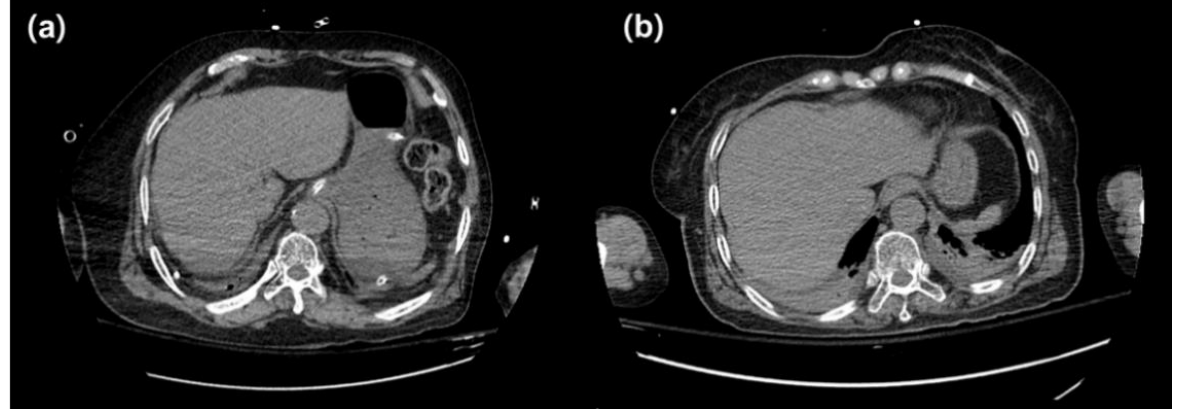
Figure 2. Abdominal CT images of patients with arms-down position in groups A and B. ( a ) Axial image in a group A patient (M, 75 years, BMI: 26.12 kg/m 2 ), ( b ) axial image in a group B patient (F, 69 years, BMI: 24.44 kg/m 2 ). Although beam hardening artifacts appear in groups A and B due to the arm, it would be seen that less beam hardening artifacts appear in the dose modulation off image in patients within the normal BMI range. Table 3. Subjective image quality scores of Group A (dose modulation on) and Group B (dose mod- ulation off). Data are mean ± standard deviation.